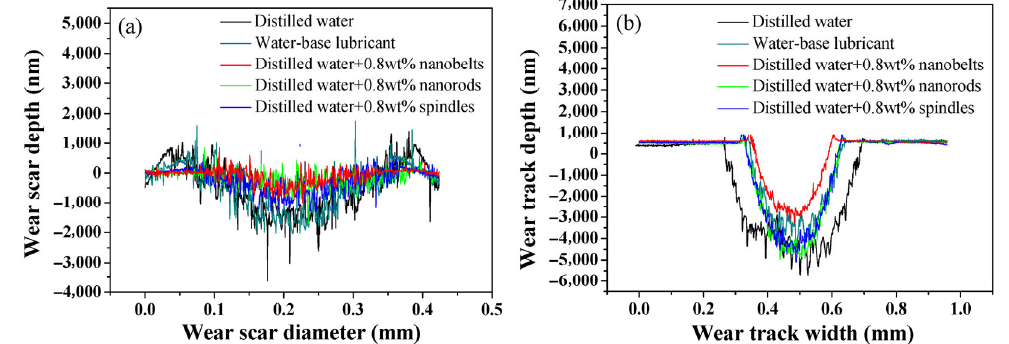
Fig. 10 The cross-section profiles of (a) wear scar on Si 3 N 4 ball and (b) wear track on 304 stainless steel plate.